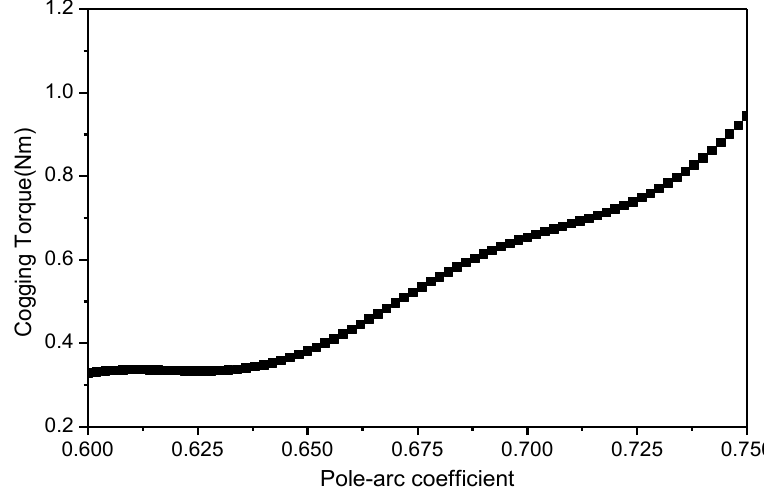
Figure 5. Relation curve between pole-arc coefficient and cogging torque.